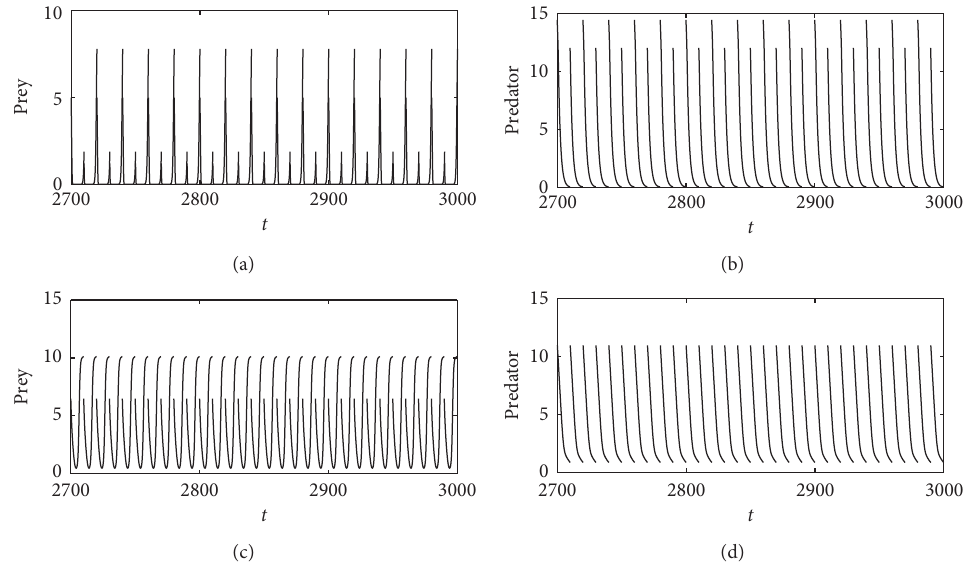
. The other parameters are identical to those in Figure 1 and K � 10 . 5 ,T � 10. 1